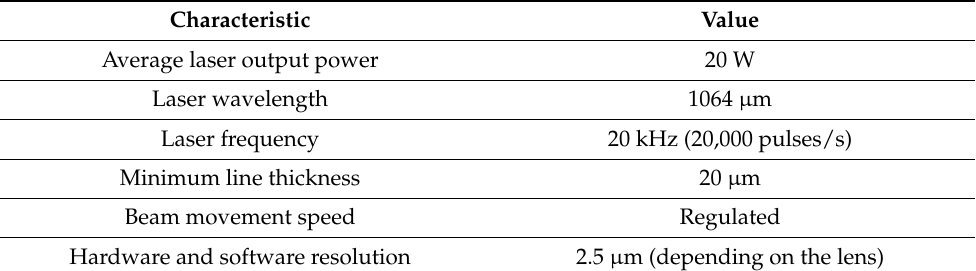
Table 1. Characteristics of the high-precision laser marking system «MiniMarker